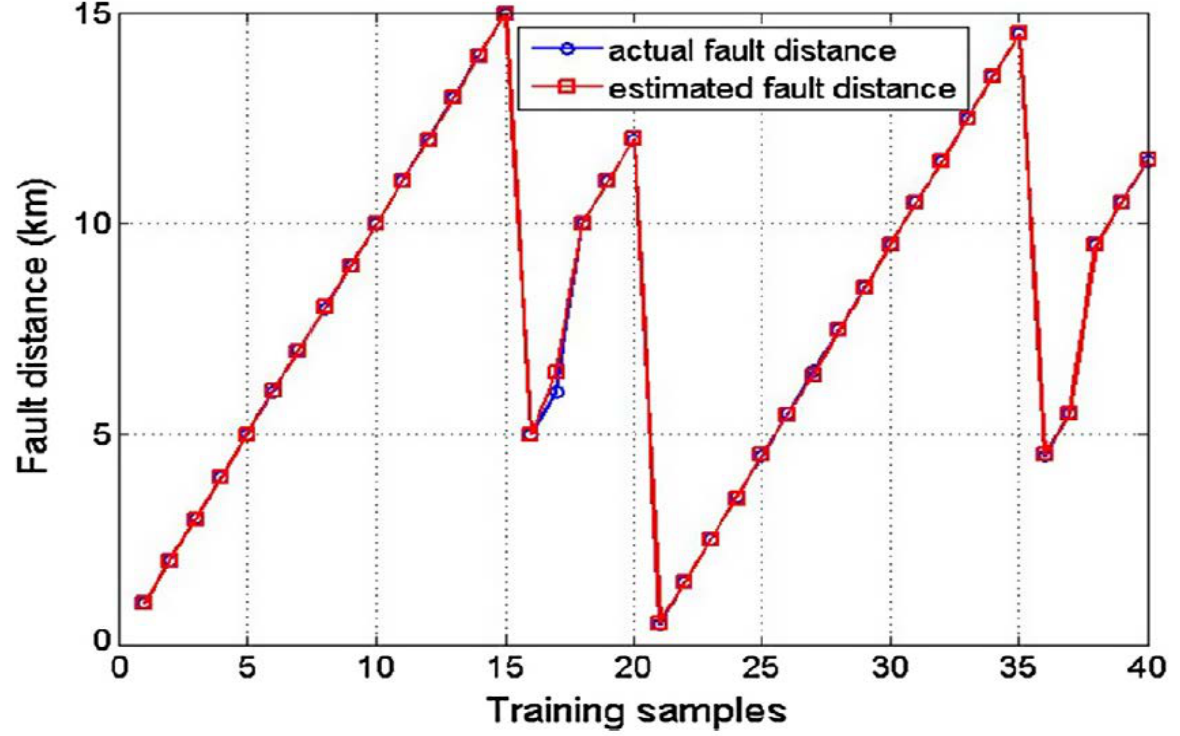
Figure 8. Fault estimation training sample using SVR.